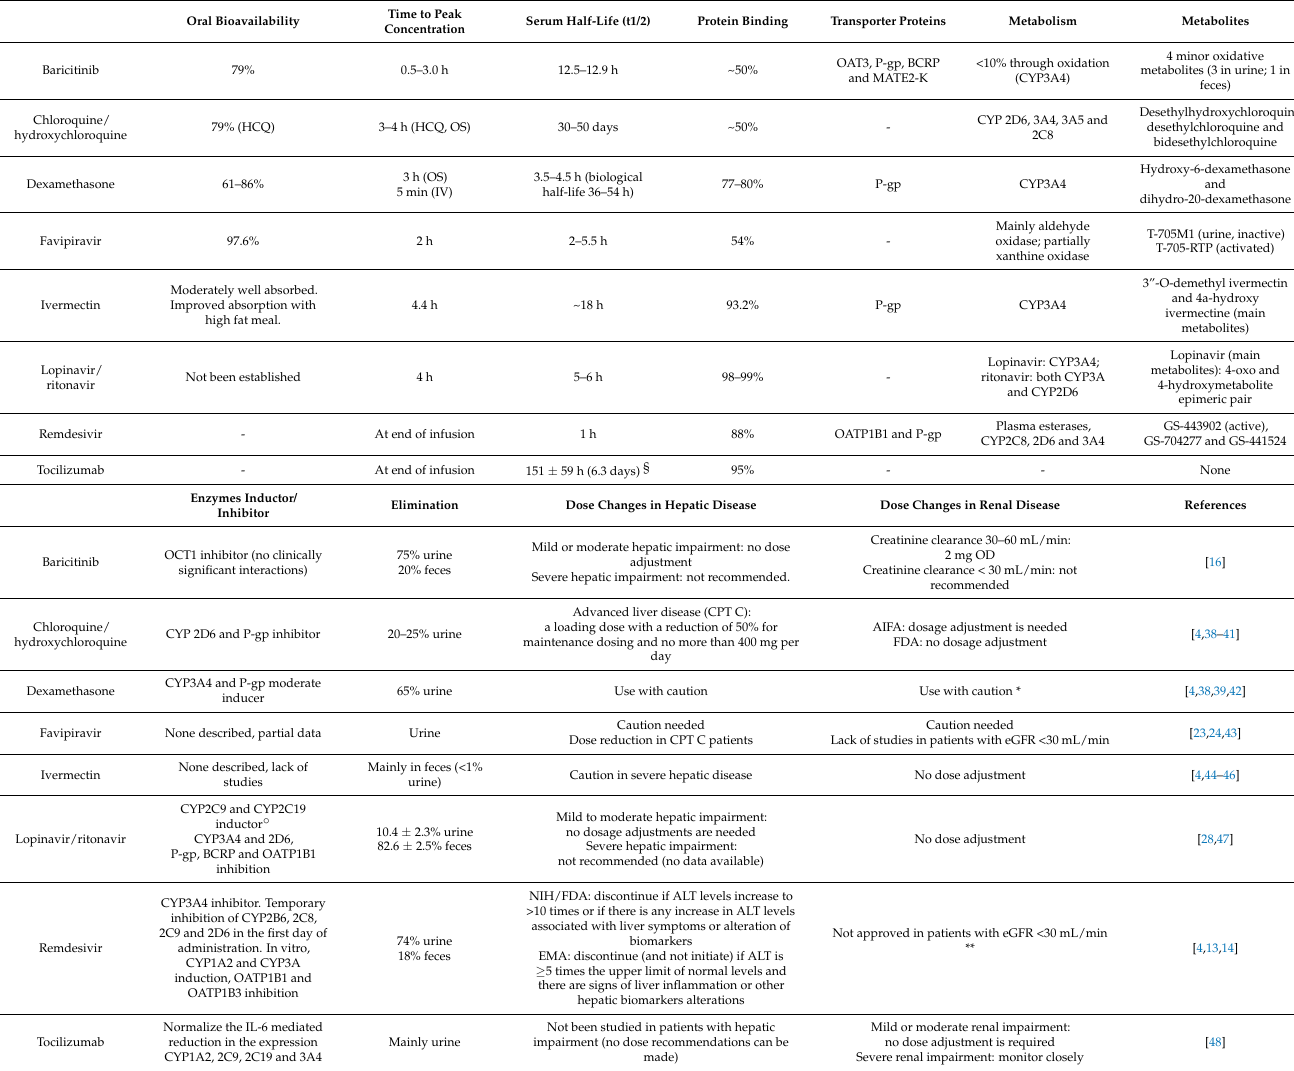
Table 3. Pharmacokinetic characteristics of COVID-19